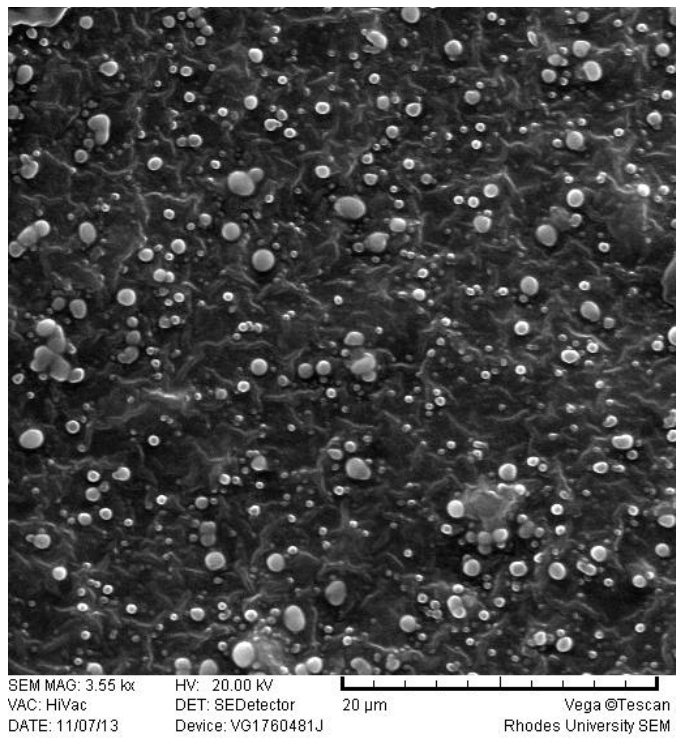
Figure 4. SEM micrograph of optimized EFV-loaded SLN.